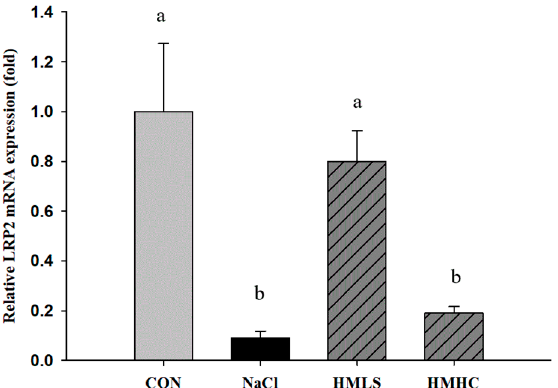
Figure 3. Effects of mineral-balanced DSW on low-density lipoprotein-related protein 2 (LRP2) expression levels: CON, normal diet + distilled water; NaCl, 8% NaCl diet + distilled water; HMLS,